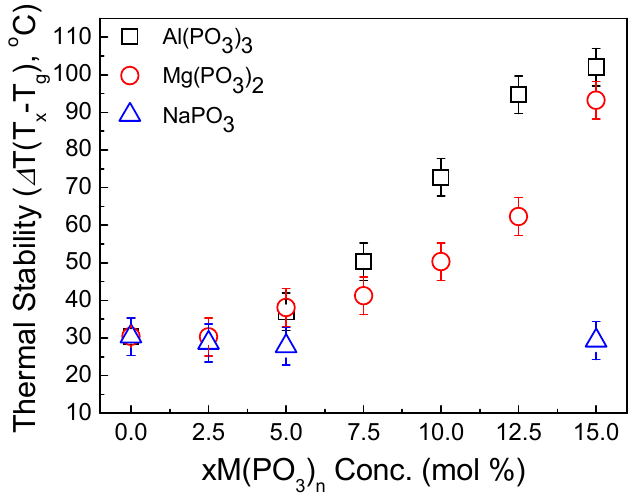
Figure 4. Variation of thermal stability with respect to xM(PO 3 ) n concentration (where M = Al, Mg, Na, n = 3, 2, 1, respectively, mol%) in (70-x)V 2 O 5 -5ZnO-22BaO-3B 2 O 3 -xM(PO 3 ) n glass system (mol%).